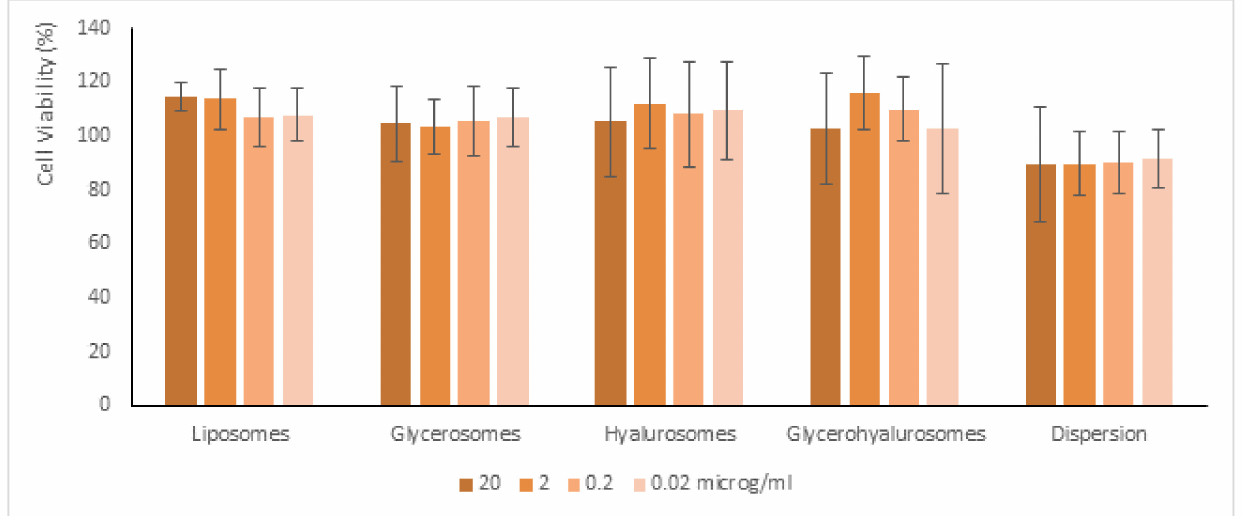
Figure 3. Expression of nitric oxide induced in cells with lipopolysaccharide and modulated by pre-treatment with canthaxanthin in dispersion or loaded in vesicles. Mean values ± standard deviations (error bars) are reported ( n = 10). Each symbol (*, ◦ ) indicates the same value ( p > 0.05 versus others).